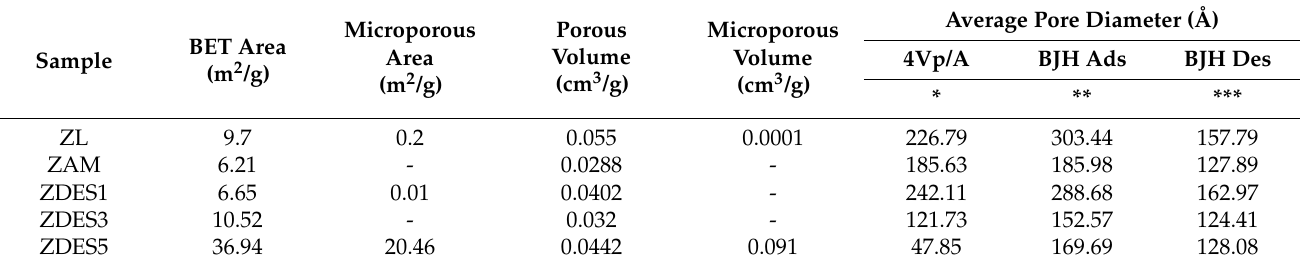
Table 3. Textural properties of the raw material (ZL); ammonia-exchanged sample (ZAM); and dealuminated samples (ZDES1, ZDES3, and